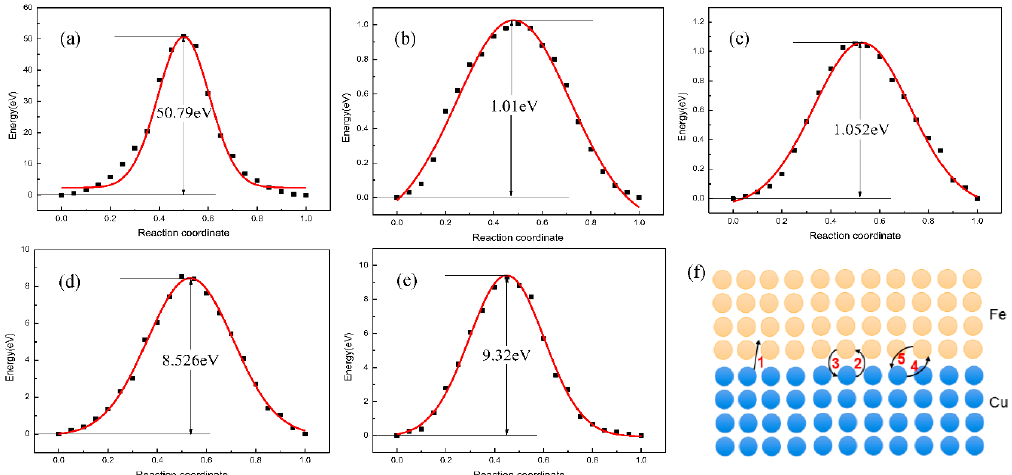
Figure 7. Atomic snapshots concerning Kirkendall effect of the Fe/Cu bimetallic interface. ( a ) the diffusion energy of the interstitial diffusion path of Cu atom; ( b ) the diffusion energy of the first